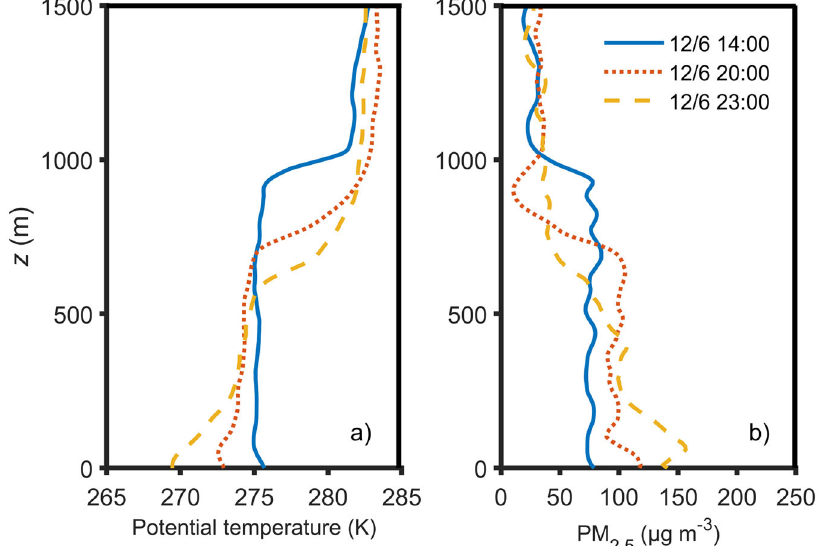
Fig. 9 Variations in the vertical distributions of potential temperature and air pollutants at Baoding station on 6 December 2019. a Potential temperature and b PM 2 : 5 concentration.